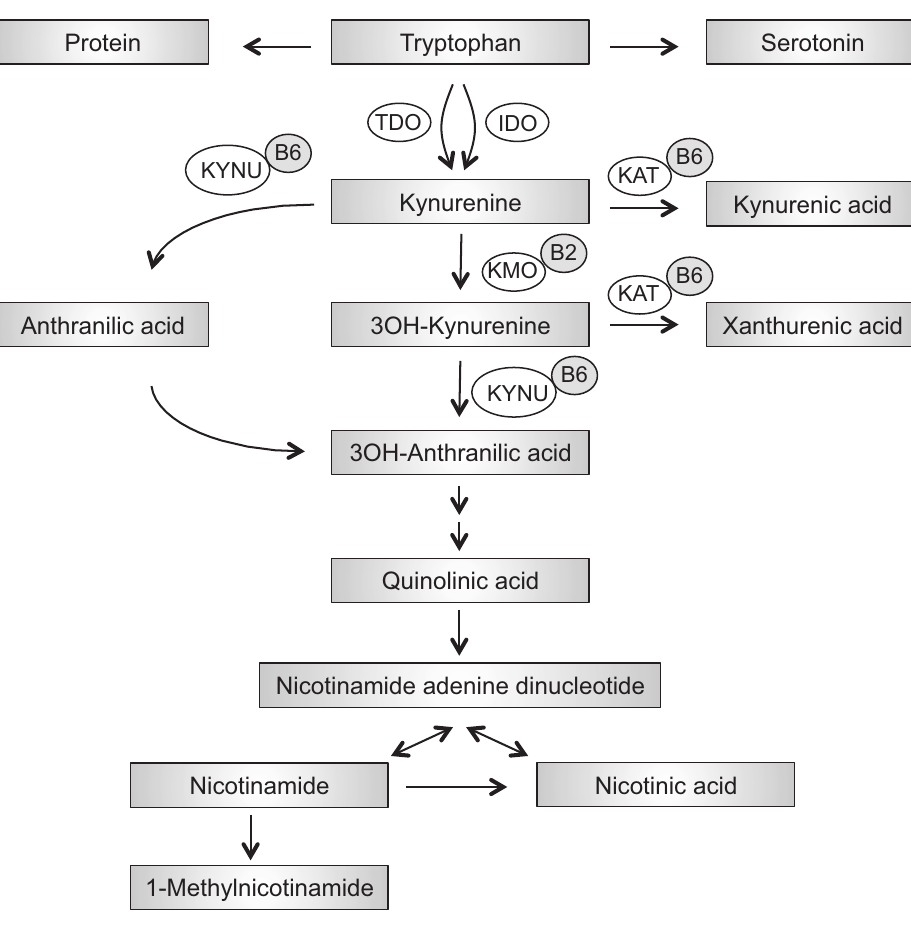
Fig 1. The kynurenine pathway of tryptophan metabolism. IDO, indoleamine 2,3-dioxygenase; TDO, tryptophan 2,3-dioxygenase; KAT, kynurenine aminotransaminase; KMO, kynurenine 3-monooxygenase; KYNU, kynureninase; 3OH-kynurenine, 3-hydroxy kynurenine; 3OH-anthranilic acid, 3-hydroxy anthranilic acid; B6, vitamin B6 (pyridoxal 5‘-phosphate); B2, vitamin B2 (flavin adenine dinucleotide).